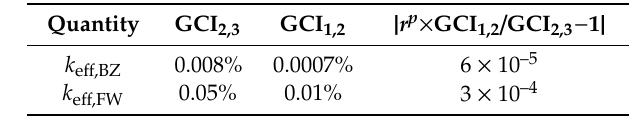
Figure 5. Grid convergence study. k eff,0 refers to the values at 0 grid size estimated with the Richardson extrapolation (RE) method. Table 1. Results of the grid independence study.